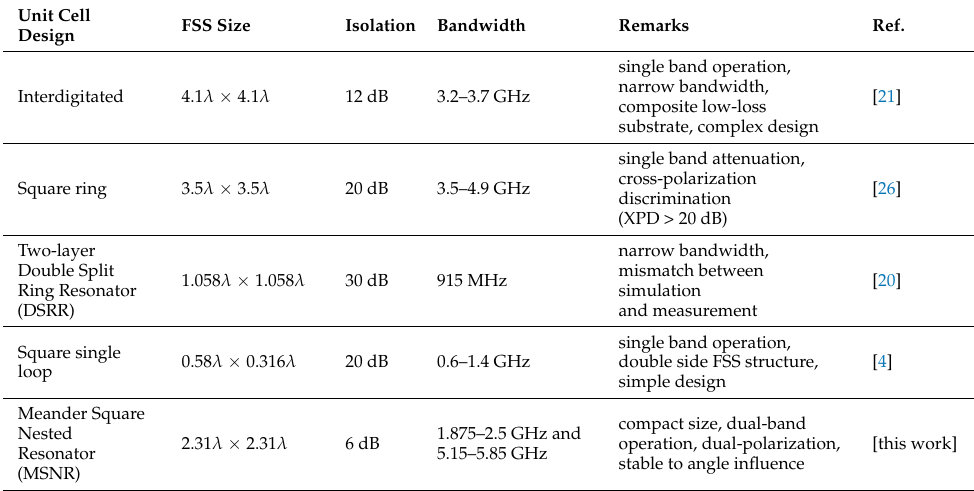
Table 3. Compilation of the proposed FSS with relevant